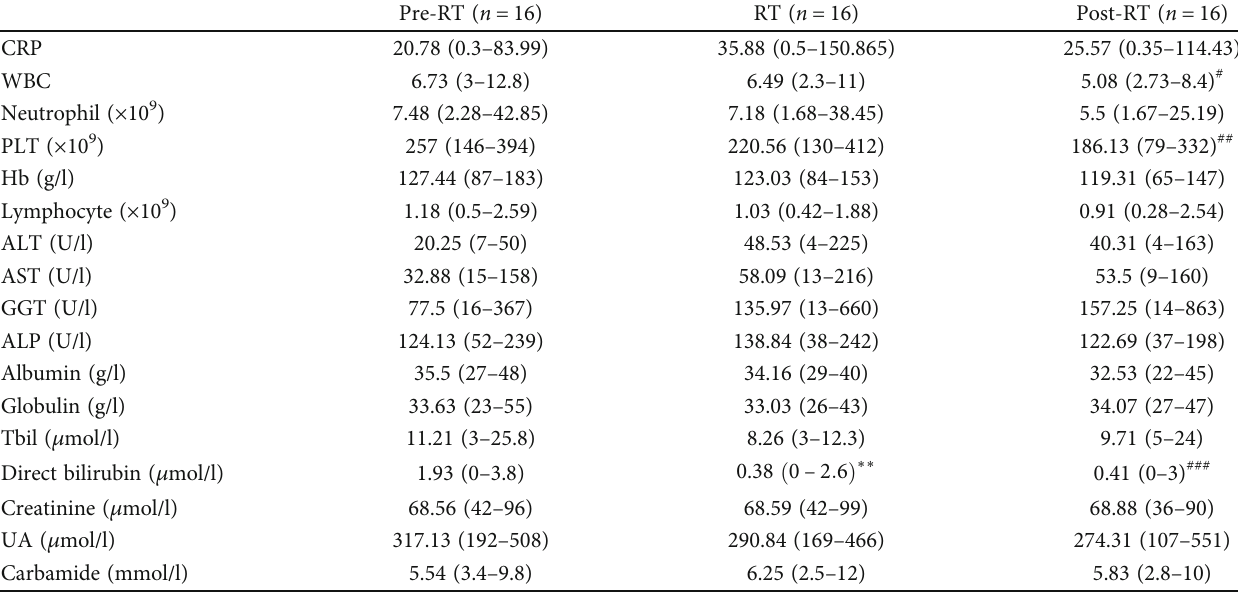
Table 4: Results of blood biochemical indices in NSCLC patients at di ff erent stages of